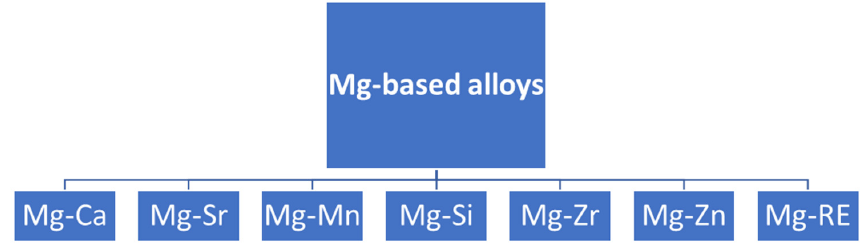
Figure 2. Classification of magnesium-based alloys [8].